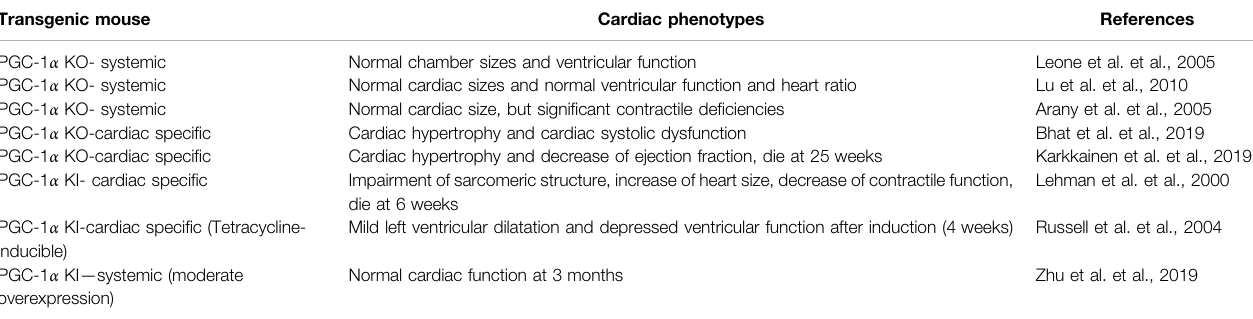
TABLE 1 | Cardiac phenotypes of PGC-1 α KO and PGC-1 α